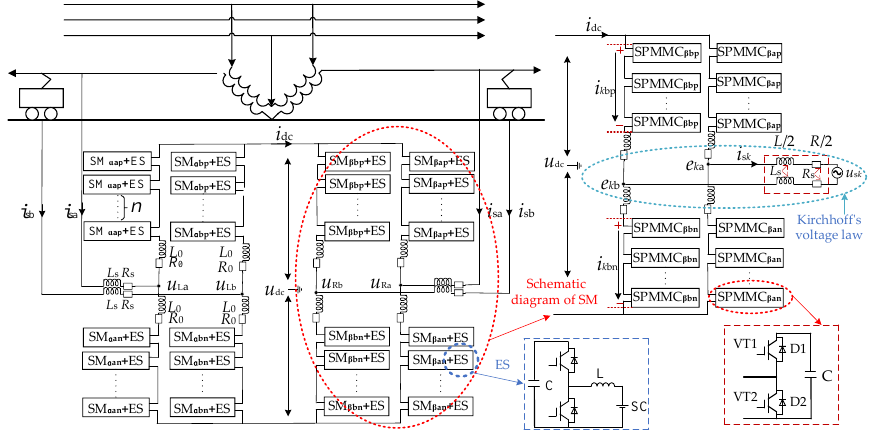
Figure 1. Topology of MMC-RPC.